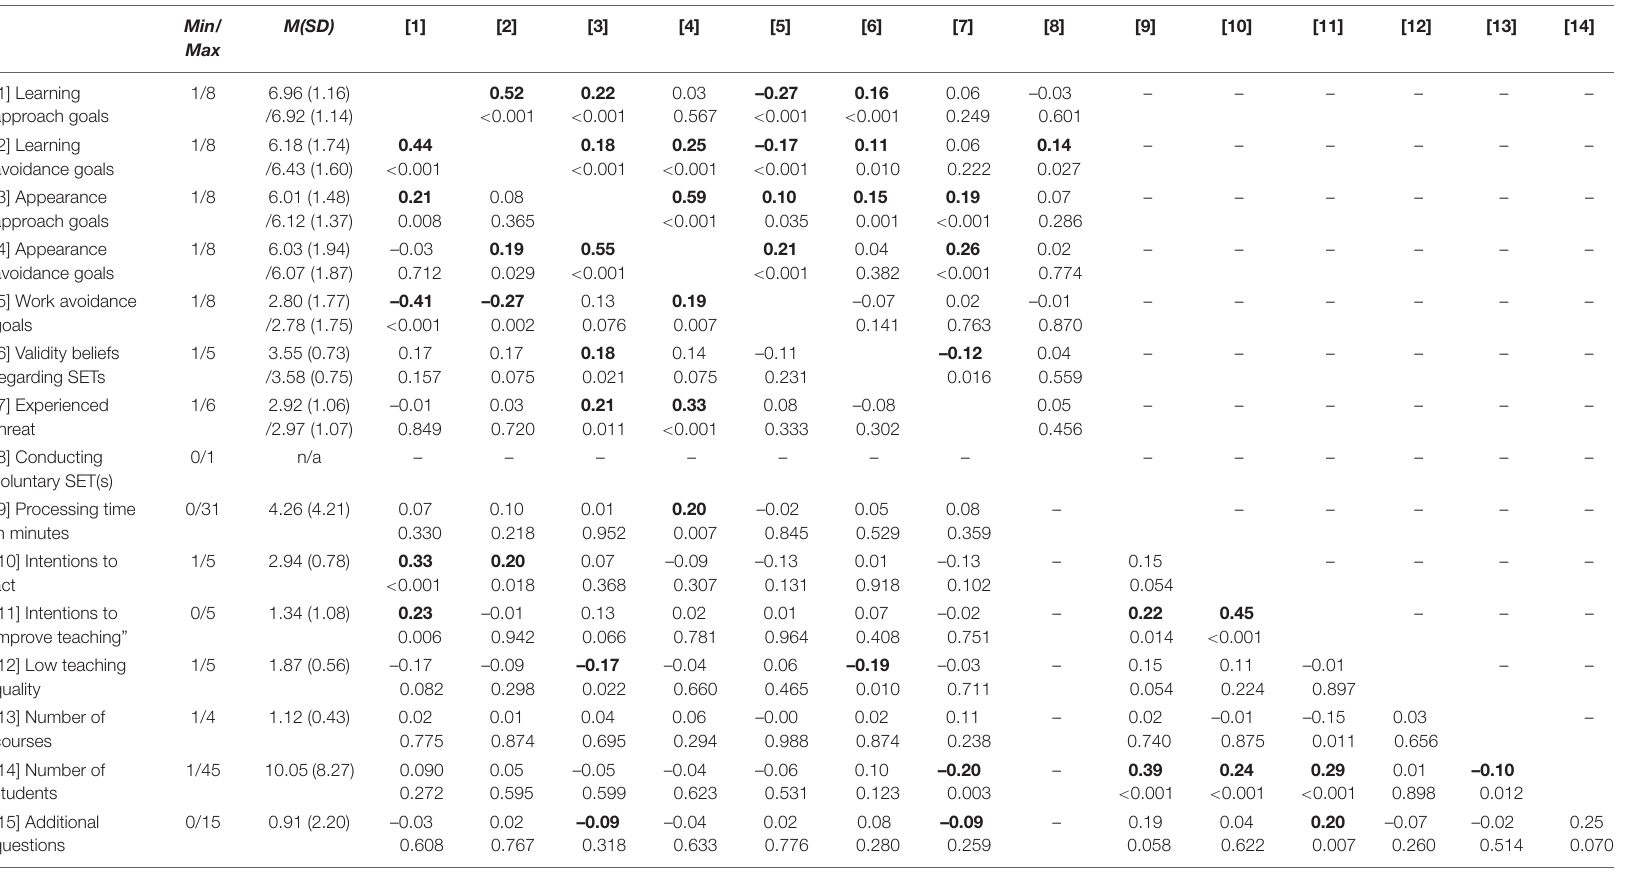
TABLE 1 | Descriptive statistics for all variables and